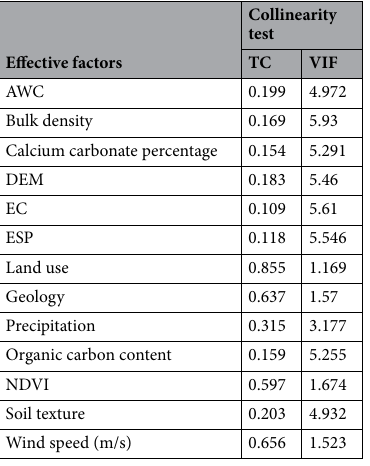
Table 1. Values of the TC and VIF for examining multicollinearity among the effective factors for wind erosion using the training